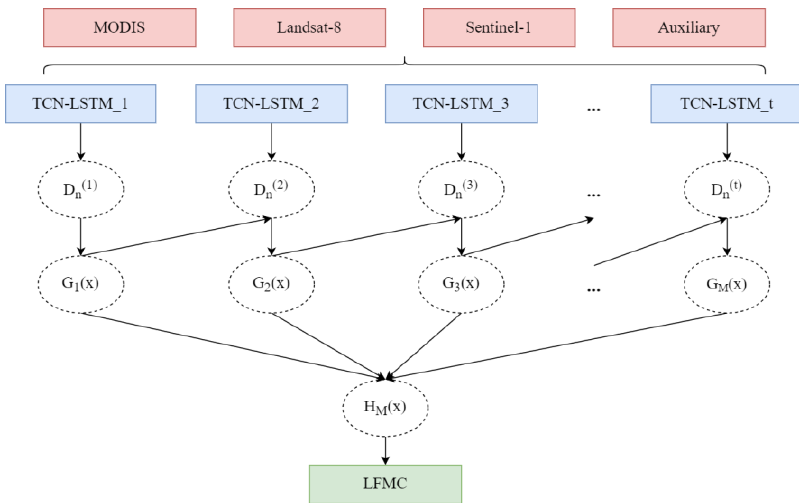
Figure 4. Structure of Adaboost ensemble model.